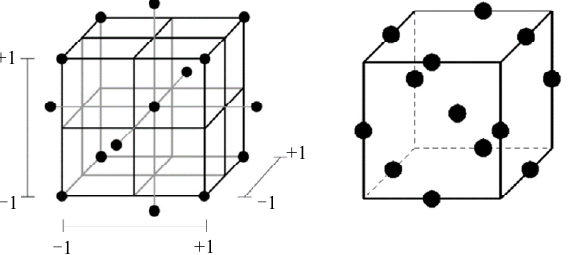
Figure 7. Central composite design (CCD) and Box-Behnken design (BBD).